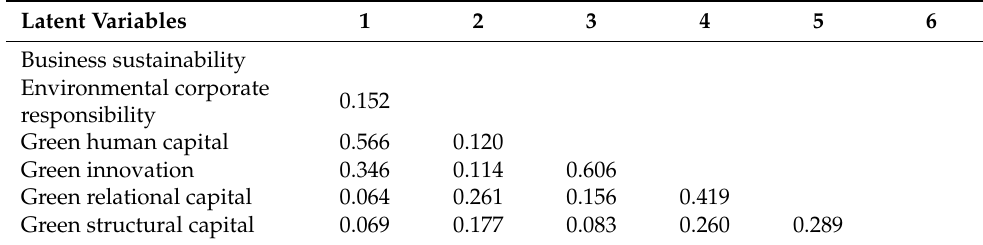
Table 6. Discriminant Validity Hetero-trait–Mono-trait Ratio (HTMT).